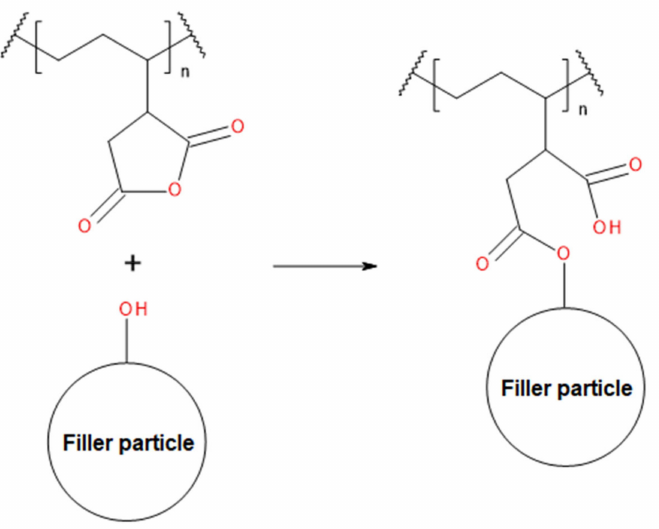
Figure 10. The general scheme of interactions between maleic anhydride and hydroxyl groups present on the surface of filler